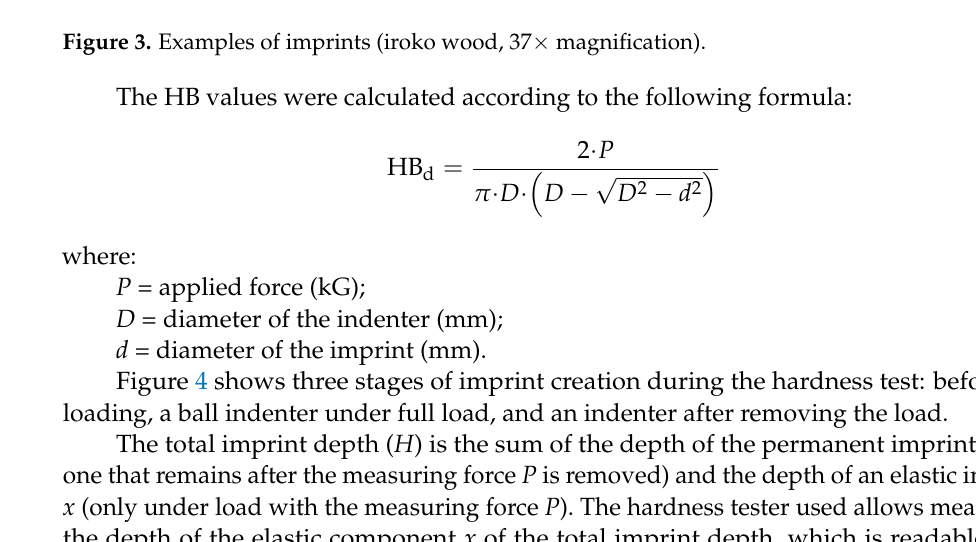
Figure 4. The imprint creation during hardness tests: ( a )—stage 1, the ball without load, ( b )—stage 2, the ball loaded with measuring force, ( c )—stage 3, the permanent indentation after a force is re- moved ( P —measuring force, D —diameter of the ball, d —the permanent imprint diameter, H —the total imprint depth, h —the permanent (plastic) imprint depth, x —the elastic (temporary) compo- nent of imprint